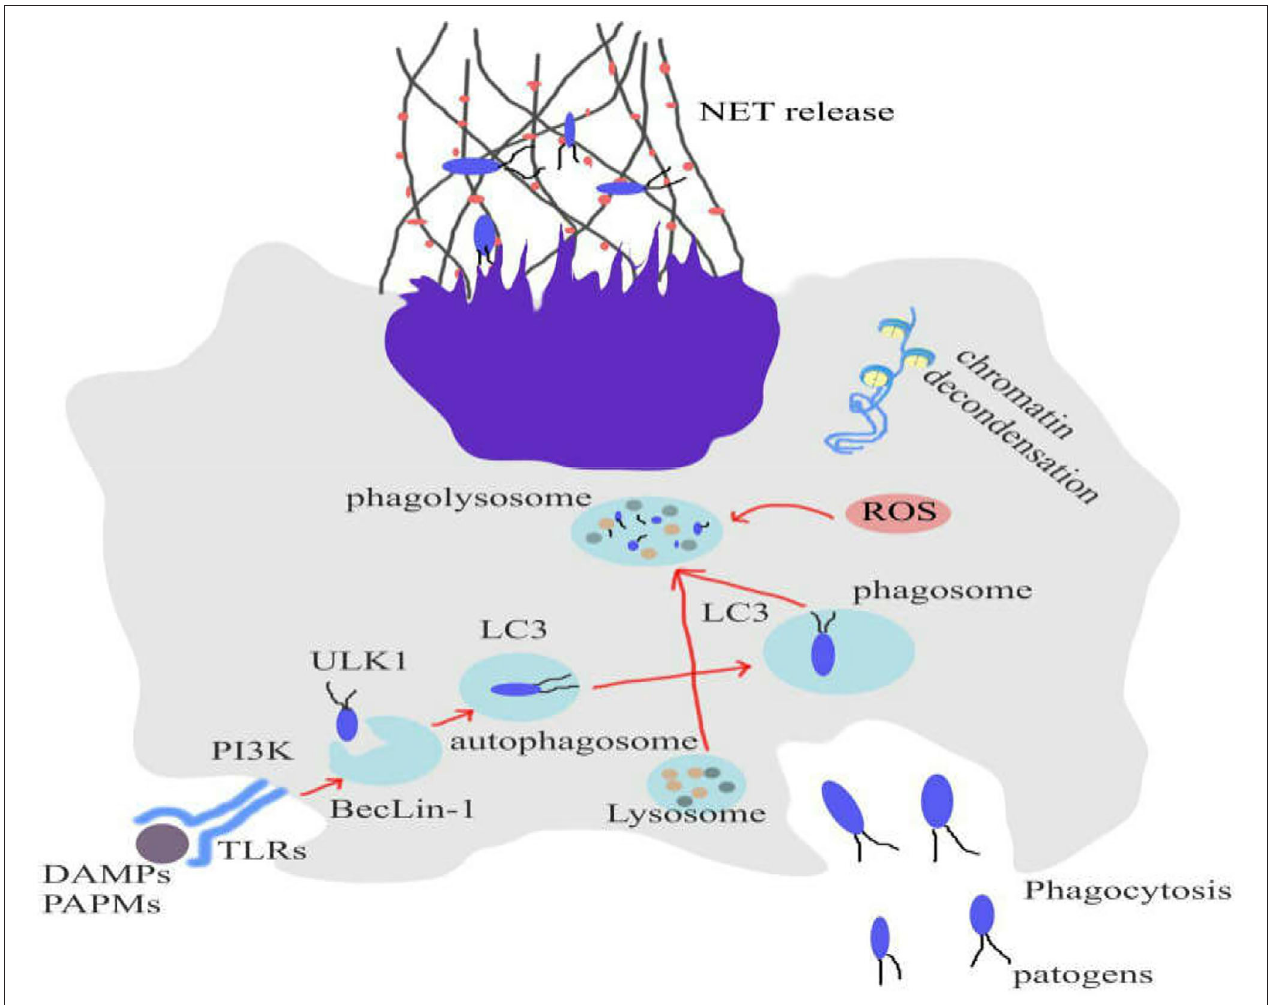
FIGURE 1 | Role of autophagy and ROS production to form NETosis. Inhibition of either NADPH oxidase or autophagy could prevent the chromatin decondensation that is crucial for NETosis, resulting in apoptotic cell death. NETosis can eliminate infections and tumors.